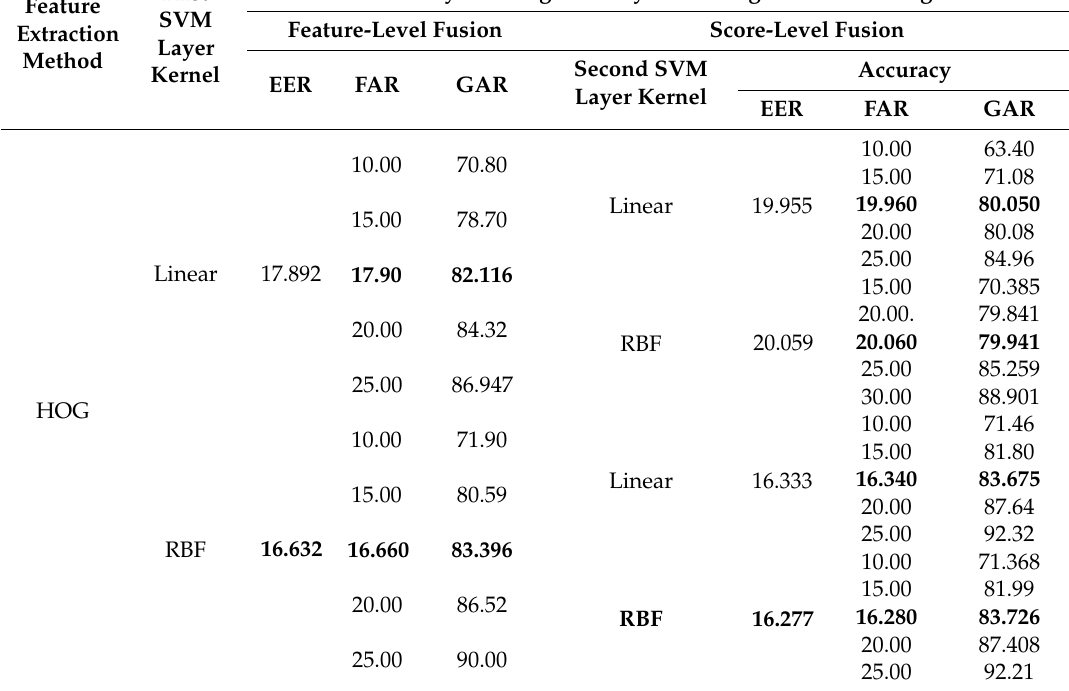
Table 5. Recognition accuracies of previous method [16] using the combination of visible light and thermal images with feature-level fusion and score-level fusion approaches (unit: %).